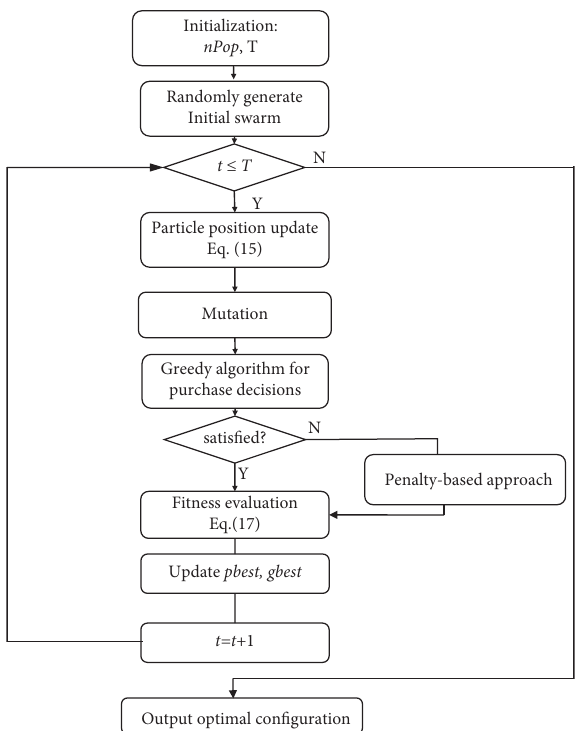
Figure 4: The two-stage algorithm for product